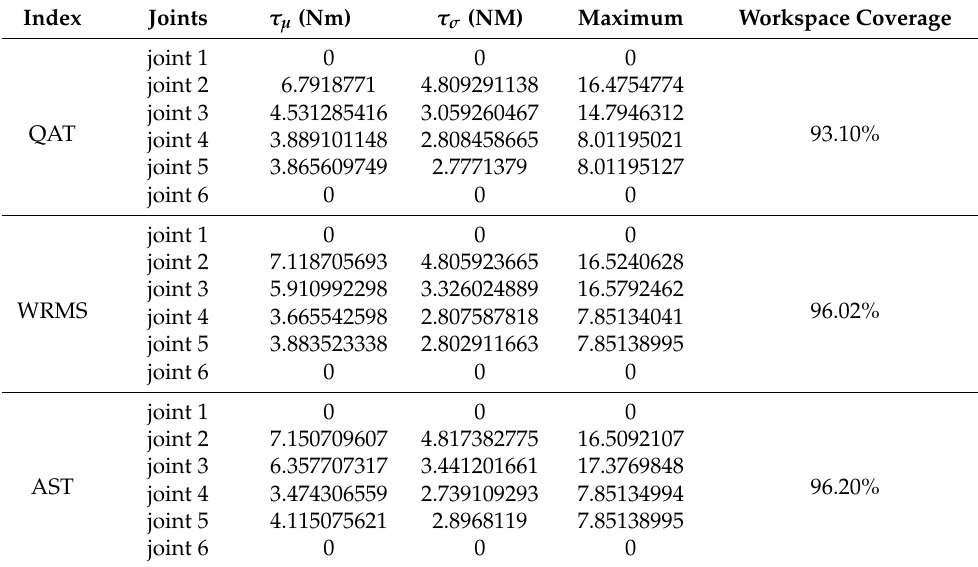
Table 6. Comparison of the mean, standard deviation, and maximum torque, and the workspace coverage of each optimal result.